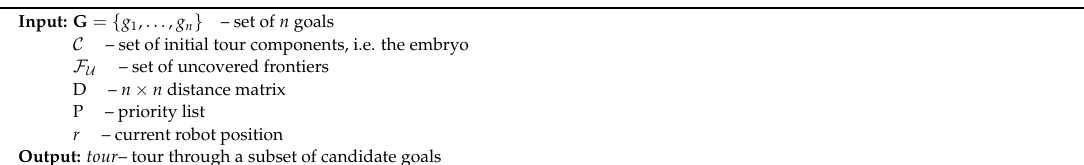
Algorithm 3: Extended nearest neighbor constructive procedure for the feasible tour generation